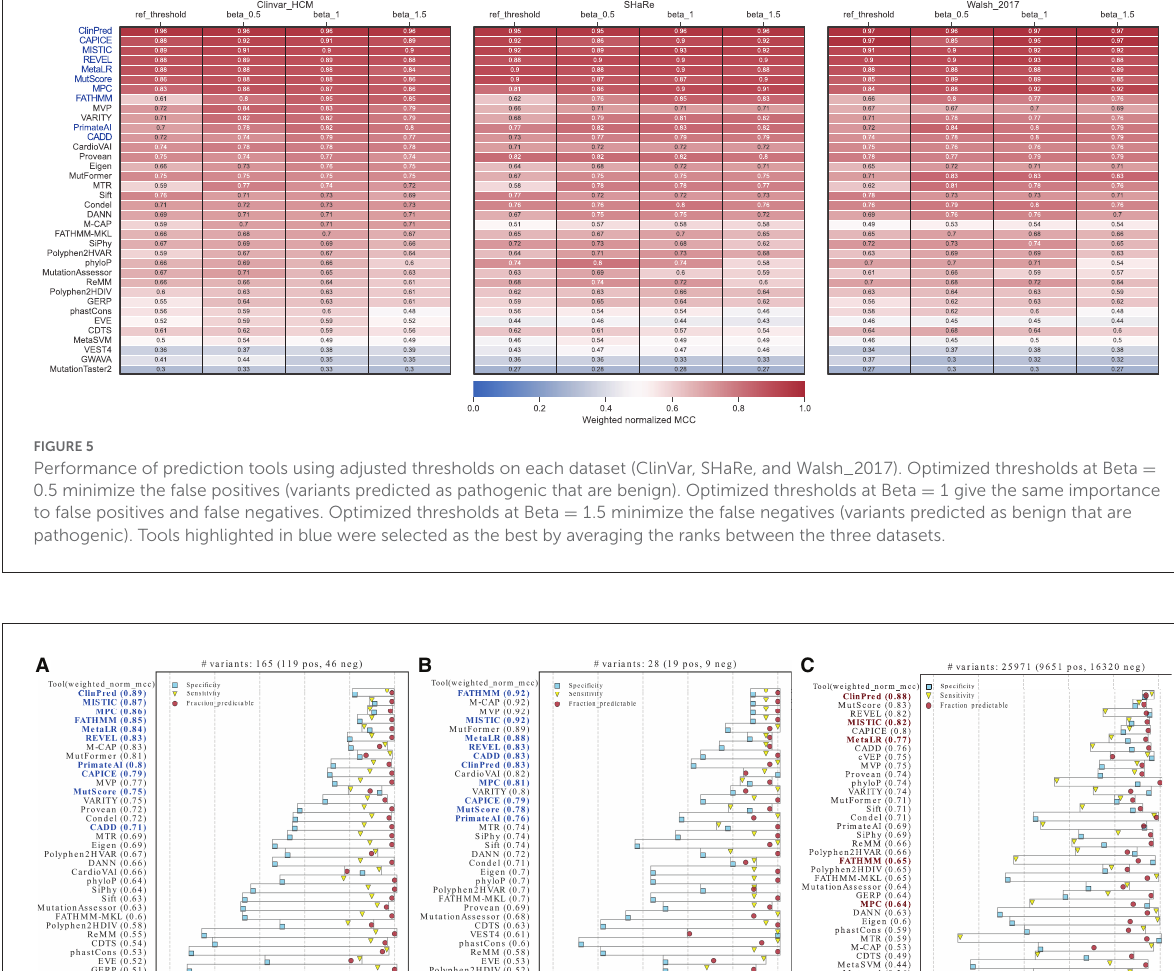
FIGURE6 Performance of prediction tools after addressing circularity issues. Tools were ranked using the weighted normalized MCC on two new test datasets (A–C) . (A) Variants identified as present in the training sets of the tools highlighted in blue were removed from the merged ClinVar, SHaRe, and Walsh_2017 datasets. (B) HCM ClinVar variants submitted after the tools highlighted in blue were developed. (C) Variants in the whole ClinVar irrespective of disease context. The tools selected as best-performers for HCM are highlighted in red